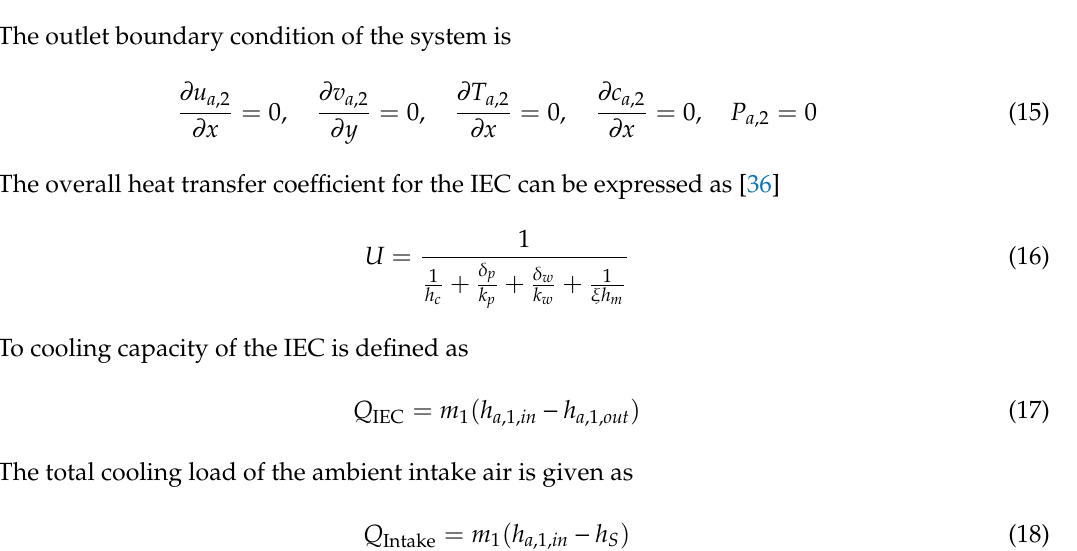
Figure 1. Schematic of the hybrid system with the integration of a pre-cooling IEC.